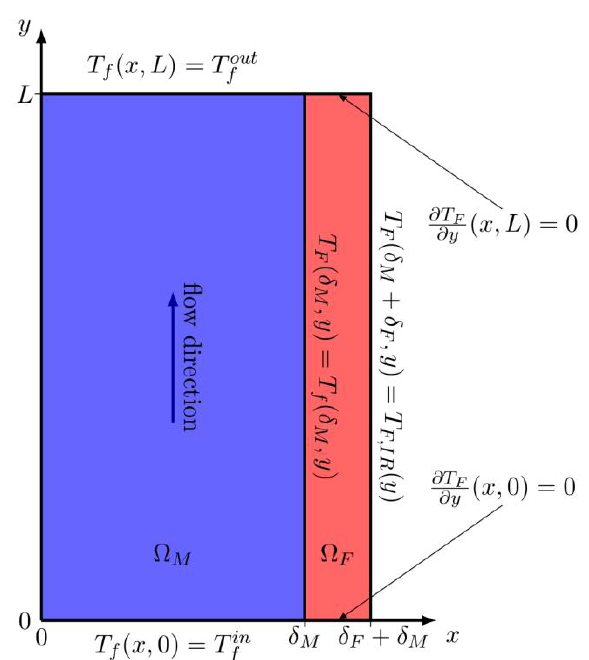
Figure 3. The boundary conditions, denotations: 𝑇 𝑓 𝑖𝑛 —the fluid temperature at the minichannel inlet, 𝑇 𝑓𝑜𝑢𝑡 —the fluid temperature at the minichannel outlet, 𝑇 𝐹,𝐼𝑅 —the foil temperature measured by an infrared camera.